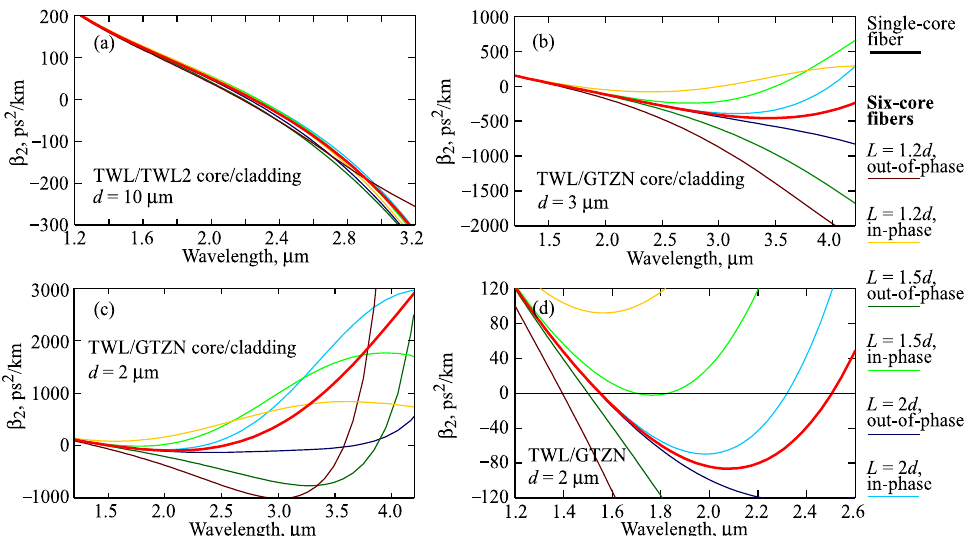
Figure 7. The calculated dispersion for six-core fibers with different L / d ratios compared to the dispersion of one-core fibers for TWL/TWL2 core/cladding with d = 10 µ m ( a ); for TWL/GTZN core/cladding with d = 3 µ m ( b ); and for TWL/GTZN core/cladding with d = 2 µ m in a wide wavelength range ( c ) and at a magnified scale near ZDWs ( d ). The effective mode field areas (left column) and nonlinear Kerr coefficients (right col- umn) for TWL/TWL2 core/cladding fibers with d = 10 µ m are demonstrated